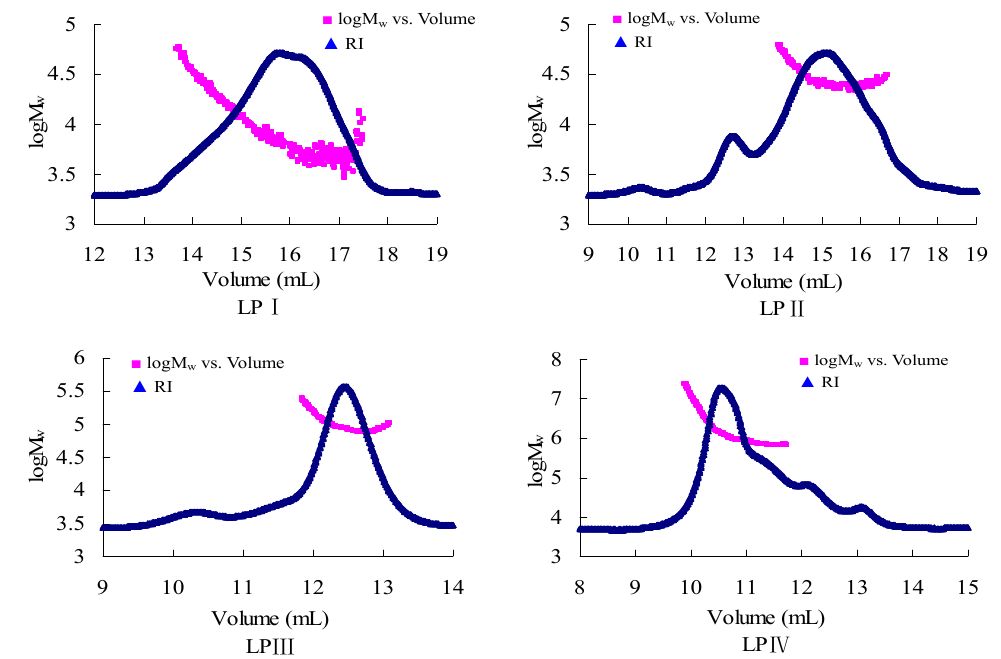
Figure 1. The size-exclusion chromatograms of longan polysaccharide fractions LPI–IV detected by a refractive index detector in water at 25 °C.